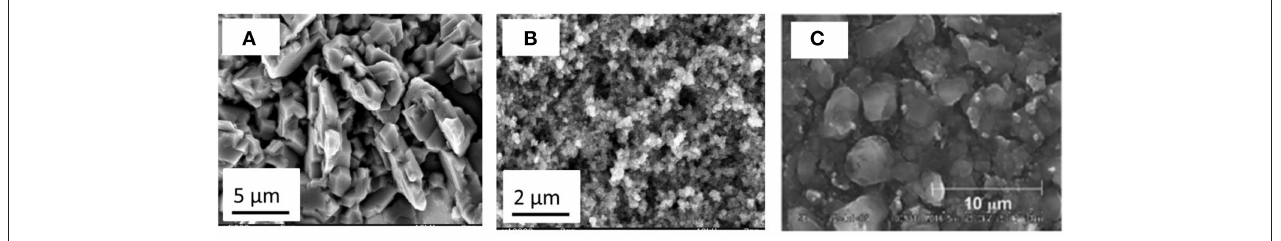
FIGURE 4 | (A) Microstructure of electrodeposited Al from [EMIm]Cl/AlCl 3 at − 0.3V vs. Al and (B) from [Py 1,4 ]Cl/AlCl 3 at − 0.3V vs. Al for 1h (C) Al electroless deposited from [EMIm]Cl/AlCl 3 in presence of LiH as reducing agent. Reproduced from Koura et al. (2008) with permission from The Electrochemical